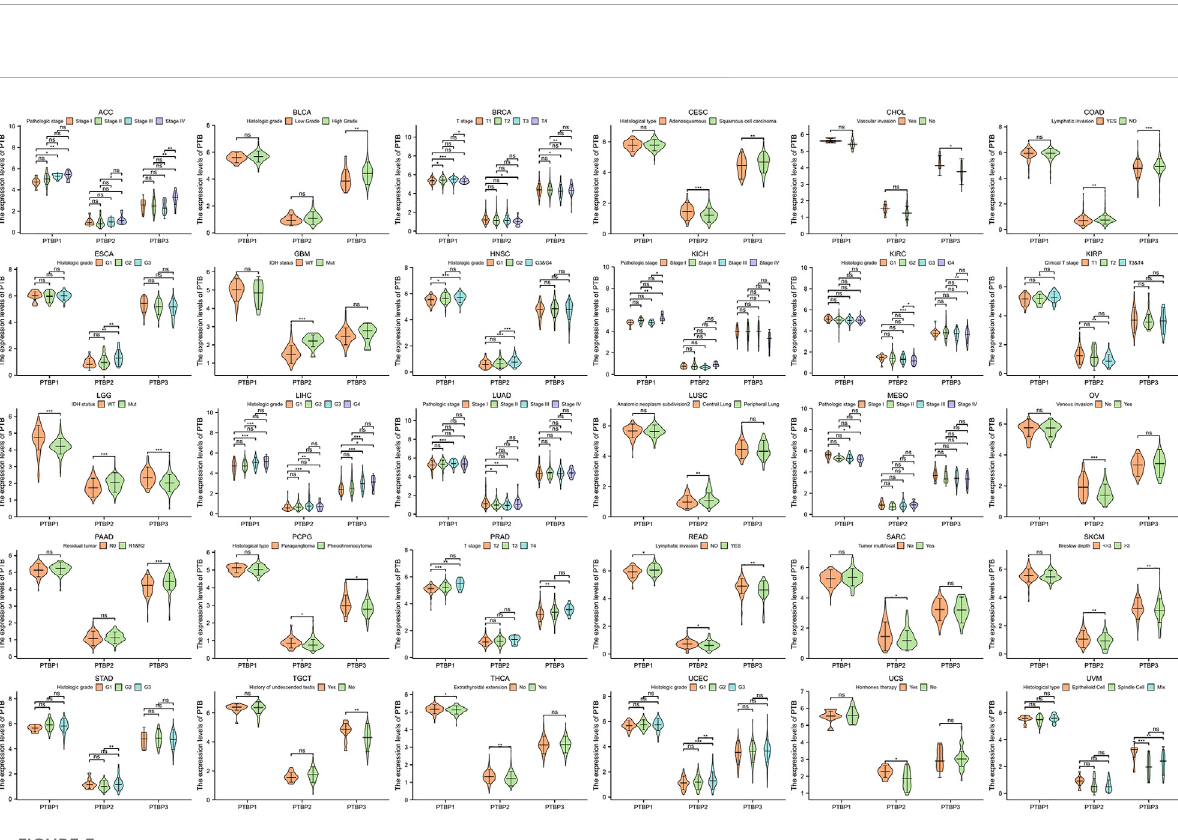
FIGURE 3 Expression levels of PTBPs in clinical parameters of interest (* p < 0.05; ** p < 0.01; *** p < 0.001; ns: not signi fi